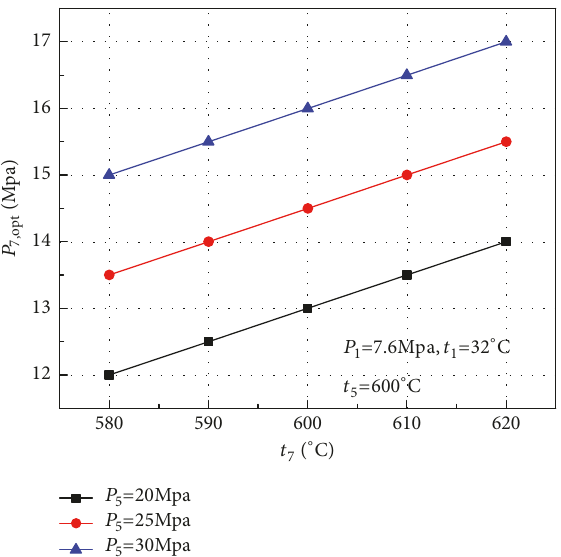
Figure 11: Optimal reheat pressure under different HPT inlet pressure and LPT inlet temperature.